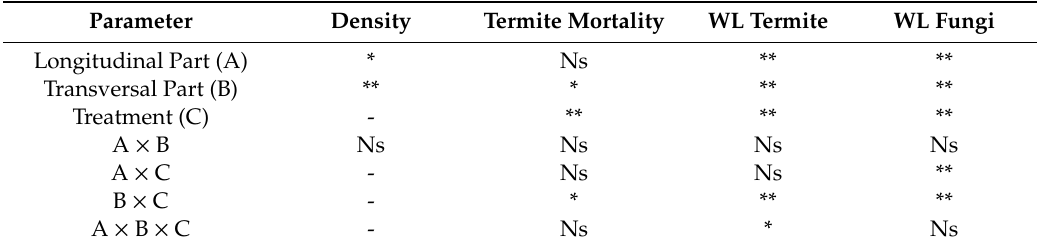
Table 4. Variance analysis summary of density, termite mortality, weight loss on termite test, and weight loss on fungal test.